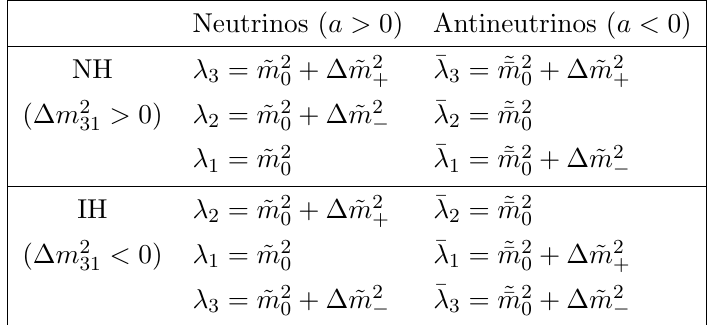
Table 1 . Relation between the eigenvalues (cid:21) i , with the convention (cid:21) i a ! 0 (cid:0)(cid:0)(cid:0)(cid:0)! (cid:1) m 2 quantities ~ m 2 and (cid:1) ~ m 2 as calculated from eq. (3.4) with the corresponding sign of a for (cid:23)= (cid:22) (cid:23) (cid:6) 0